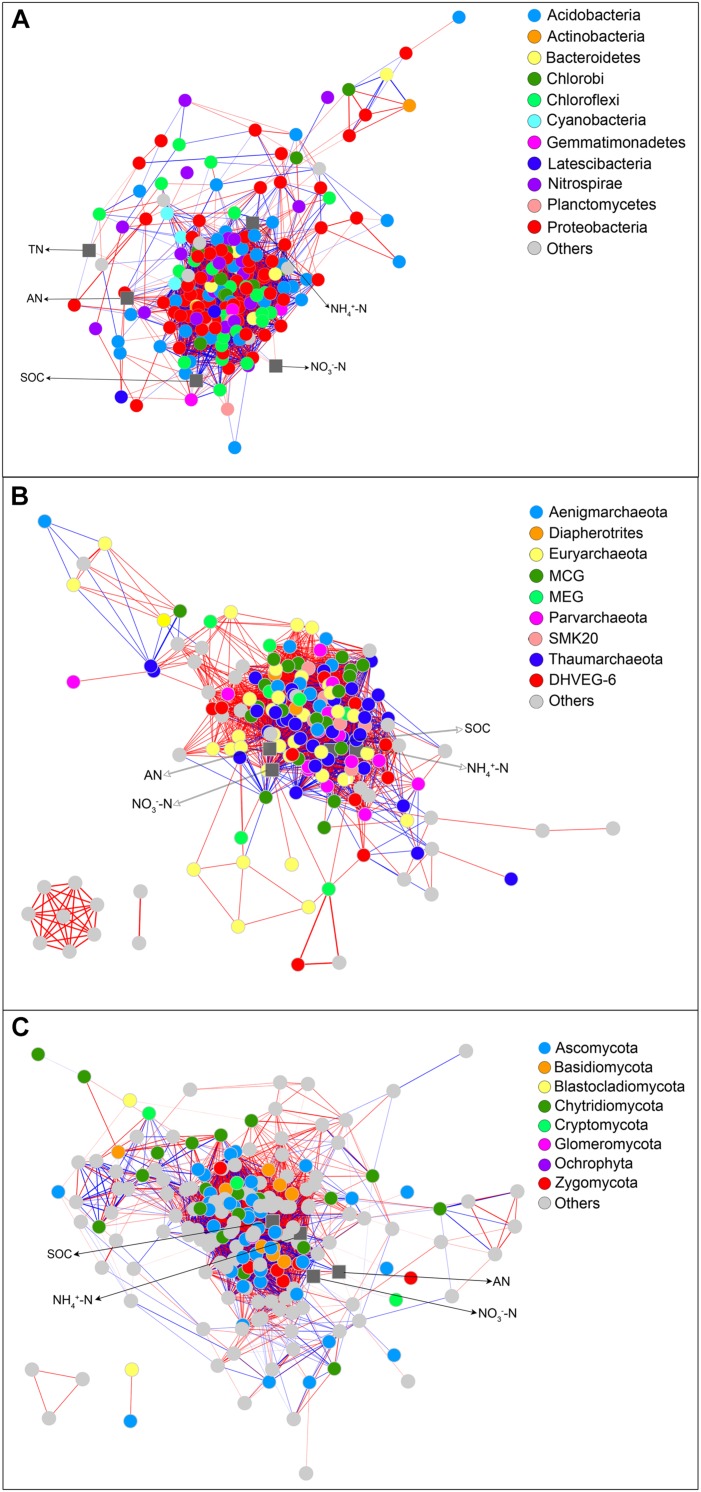
Correlation network between differentially abundant OTUs in bacterial (A), archaeal (B), and fungal (C) communities and soil properties. Blue and red lines represent significantly negative (P < 0.01, r < −0.8) and positive (P < 0.01, r > 0.8) correlations, respectively. Colored nodes signify corresponding OTUs assigned to major phyla. Soil properties are indicated with a rounded rectangle. SOC, soil organic C; TN, total N; NO3−-N, nitrate nitrogen; NH4+-N, ammonium nitrogen. CR, conventional rice cultivation; RF, rice-frog cultivation.